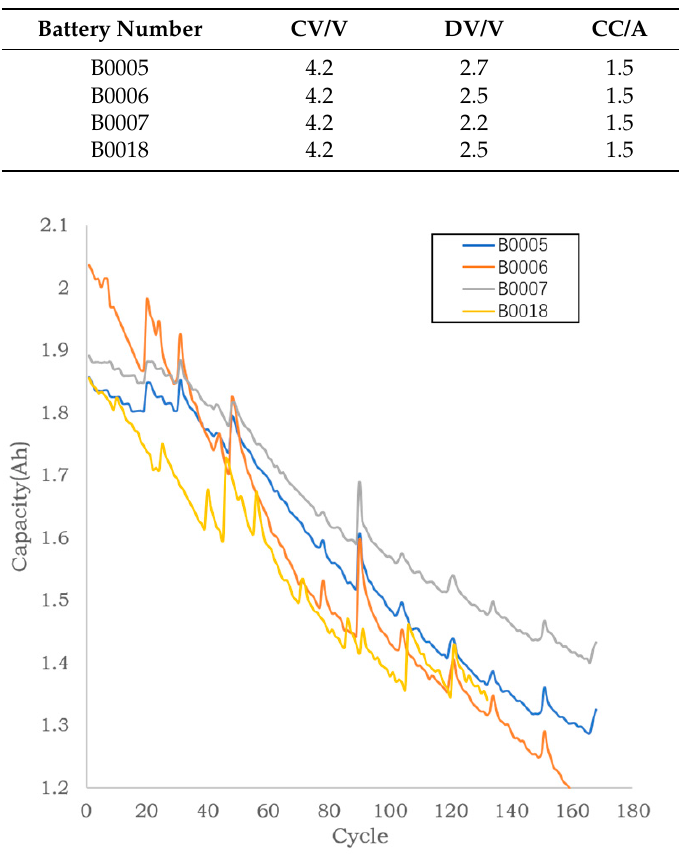
Figure 3. Capacity change curve of NASA PCoE data.